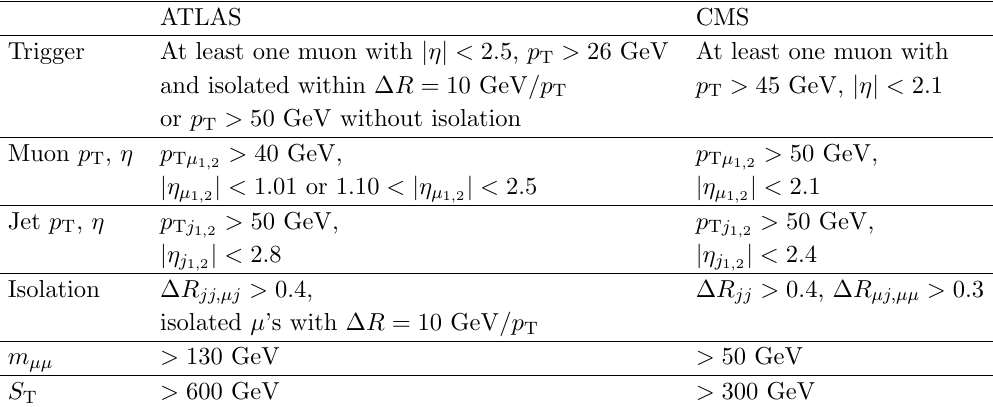
Table 14 . Summary of selection cuts for ATLAS [8] and CMS [9] searches for pair-produced S